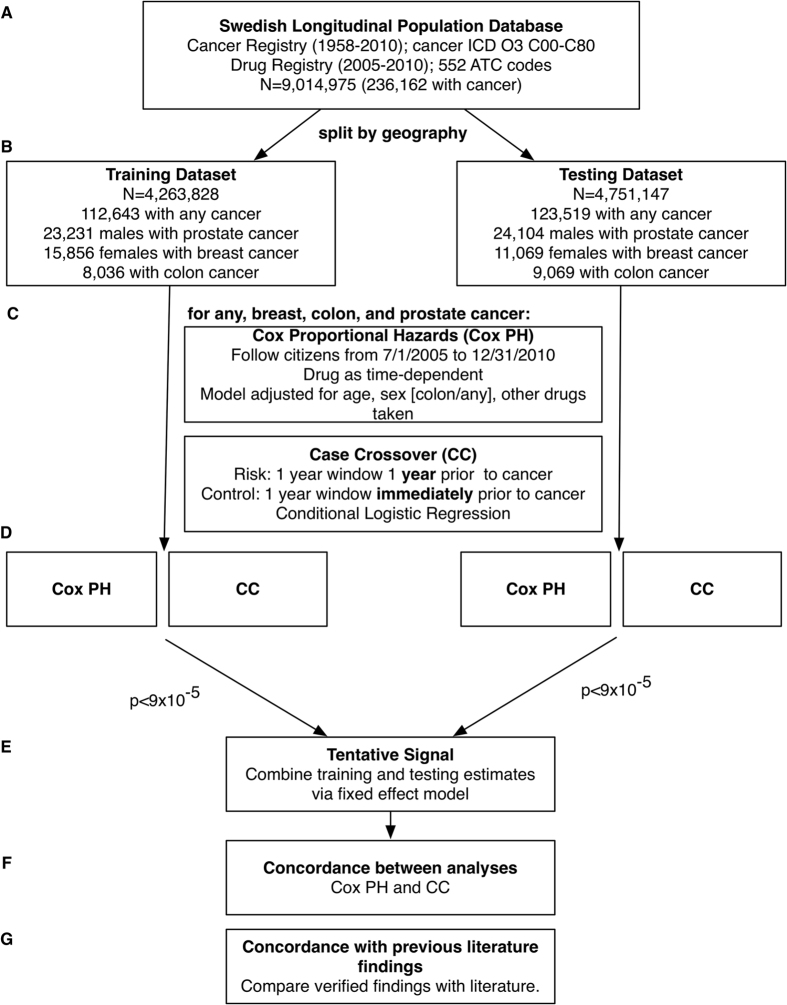
Overview of method to associate 552 medications with cancer risk.(A) The data source was the Swedish longitudinal database, consisting of the Cancer Registry and Prescribed Drug Register (“ATC” = Anatomical Therapeutic Classification). (B) We split data into a training and testing dataset by location. (C) We conducted 2 possible analyses for each cancer type (e.g., any, breast, colon, and prostate) with (B), Cox proportional hazards regression (Cox PH), and a Case-Crossover (CC) analyses, only adjusting for sex in the any cancer or colon cancer outcomes, (D) Association testing. (E) Claiming a verified signal (p < 10−5 in both training and testing datasets) (F) Estimate concordance between each analysis, and (G) Estimate concordance between each analysis and the previous literature.